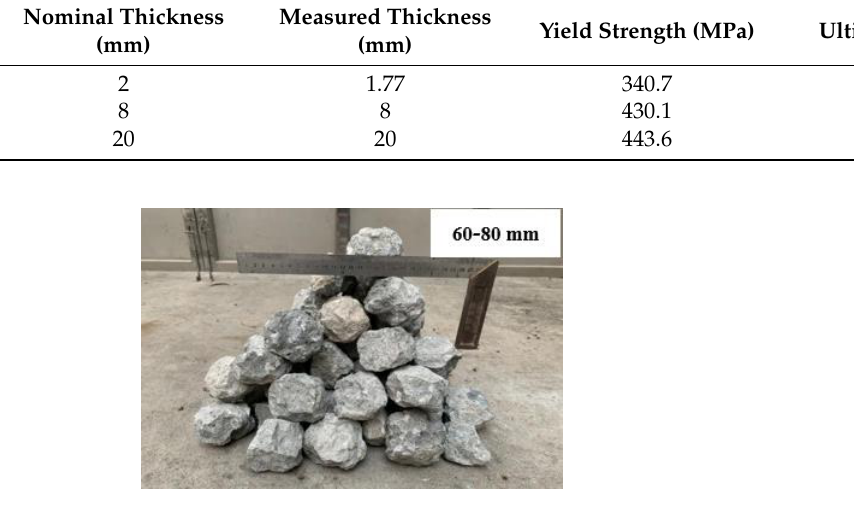
Figure 3. Demolished concrete lumps (DCLs).